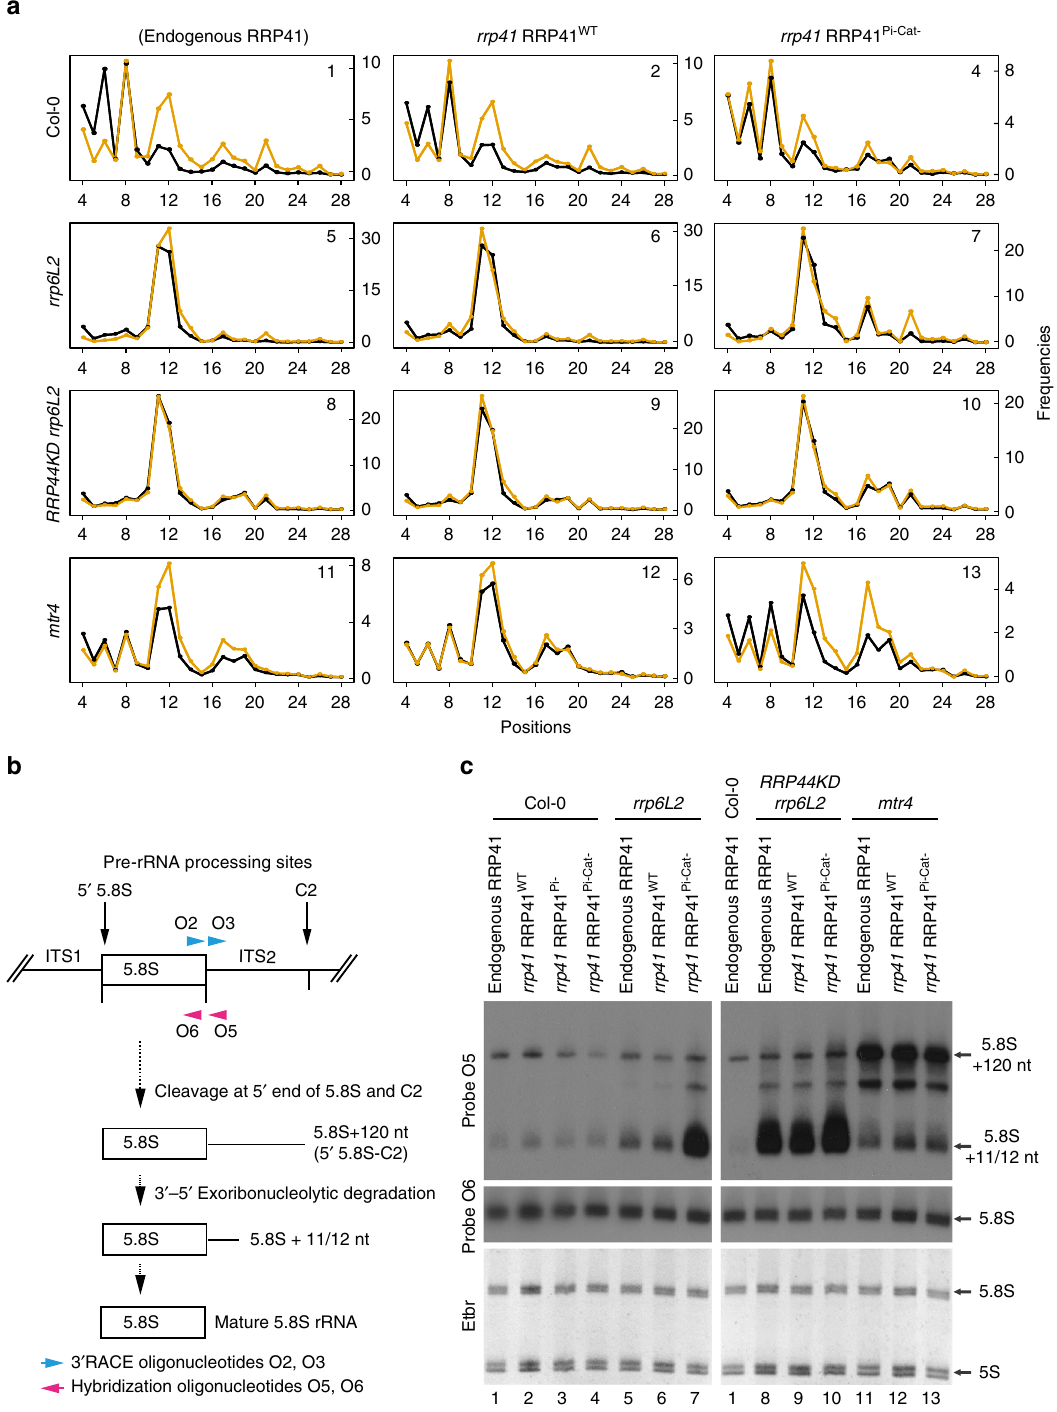
Fig. 5 Exo9 activity is involved in processing or degradation of 5.8S rRNA precursors. a High density mapping of 5.8S rRNA precursors by 3 ′ RACE-seq. Density pro fi les of 5.8S rRNA precursors degradation intermediates are shown for positions +4 to +28, +1 corresponding to the fi rst nucleotide after the mature 5.8S rRNA (see Supplementary Fig. 5). Two replicates are shown in black and orange. The presence of the endogenous RRP41 or the complementation of the rrp41 mutations by RRP41 WT or RRP41 Pi-Cat- , respectively, is indicated at the top of the panels. The Col-0, rrp6L2 , RRP44KD rrp6L2 , or mtr4 genetic background is indicated on the left. Numbering of each panel refers to the lane numbers of the northern blot shown in c . b Diagram of the 5.8S rRNA processing intermediates. Numbers refer to the transcription start site. Vertical arrows above the diagram indicate endonucleolytic processing sites. Key steps leading to the maturation of the 5.8S rRNA are sketched below. The location of the hybridization oligonucleotides O5 and O6 is shown by a magenta arrow. The location of the oligonucleotides used for 3 ´ RACE-seq is shown by blue arrows. O2 was used to map mature 5.8S rRNA mature ends (Supplementary Fig. 5), O3 to map 3 ′ ends of 5.8S rRNA precursors in a . c Northern blot analysis of the accumulation of 5.8S rRNA precursors and mature 5.8S rRNA upon inactivation of Exo9 ’ s activity. A portion of the ethidium bromide (Etbr)-stained gel is used as loading control. Lane numbers refer to the panels in